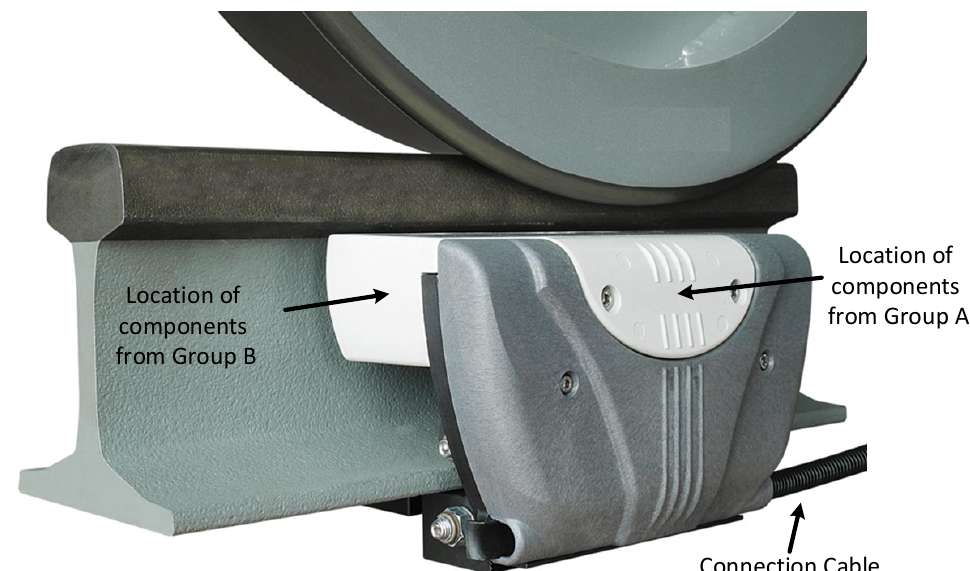
Figure 4. Photo of a wheel detector with groups indicated.